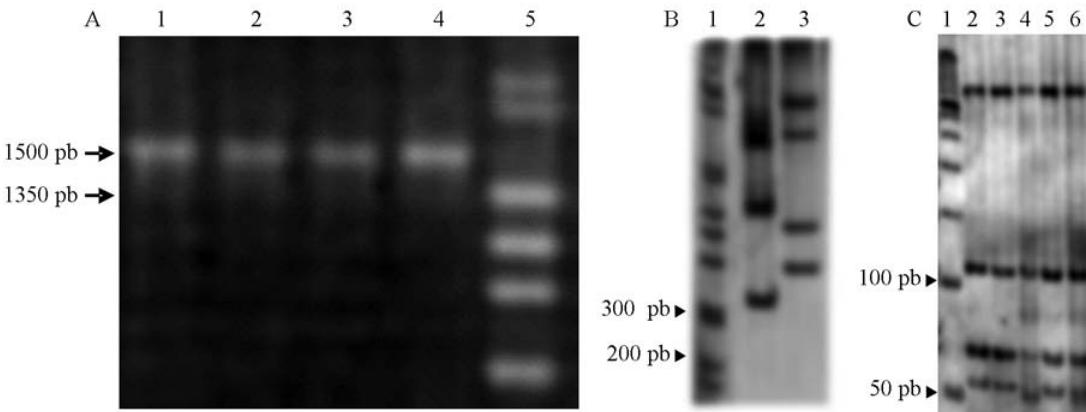
Figure 2 - A: The cpDNA PCR product of the non-coding CS region of megagametophytes and embryos of Araucaria angustifolia seeds. Lanes: (1) megagametophyte 1; (2) embryo 1; (3) Megagametophyte 2; (4) embryo 2; and (5) molecular marker λ digested with Hind III/ Hae III. B, C: Restriction fragment patterns of the cpDNA PCR products from Araucaria angustifolia . B: (1) 1 kb molecular marker; (2) and (3) patterns of the AS PCR product di- gested with RsaI, from a polymorphic (2) and a non-polymorphic individual (3). C: (1) 100 pb molecular marker; (2 to 6) patterns of the CS PCR products digested with HinfI, from non-polymorphic (2, 3 and 5) and polymorphic (4 and 6)